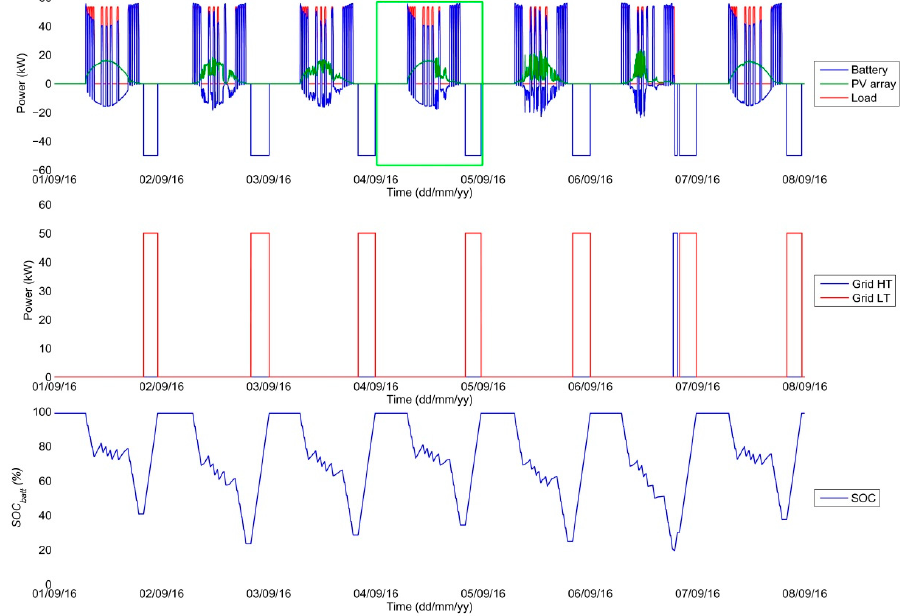
Figure 15. Resulting profiles in simulation of individual states—overall survey, scenario A.